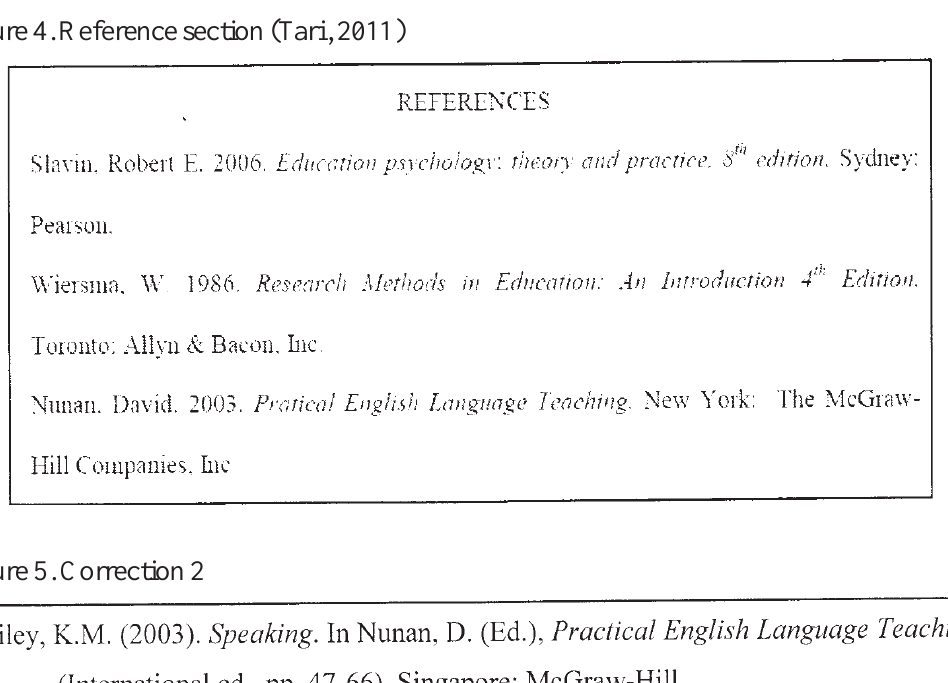
Figure 4. Reference section (Tari, 2011)